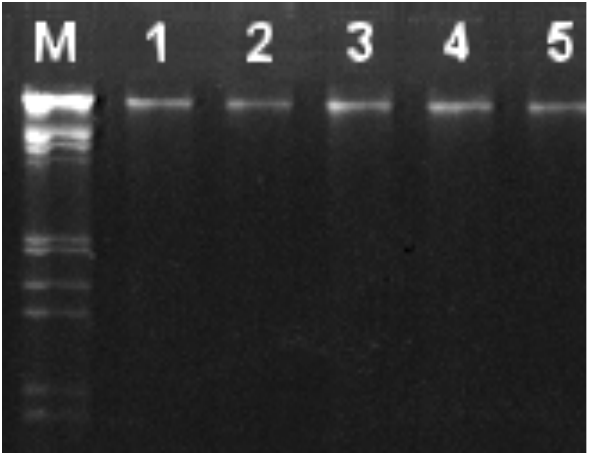
Figura 1. Eletroforese em gel de agarose 0,8 % do DNA total. M marcador de tamanho: DNA fago lambda clivado com Hind III/ Eco RI. 1-DNA total extraído de esporos de duna fixa. 2-DNA total extraído de esporos de anteduna 3-DNA total extraído de esporos de embrionária 4-DNA total extraído de esporos Gigaspora albida 5-DNA total extraído de esporos de Acaulospora